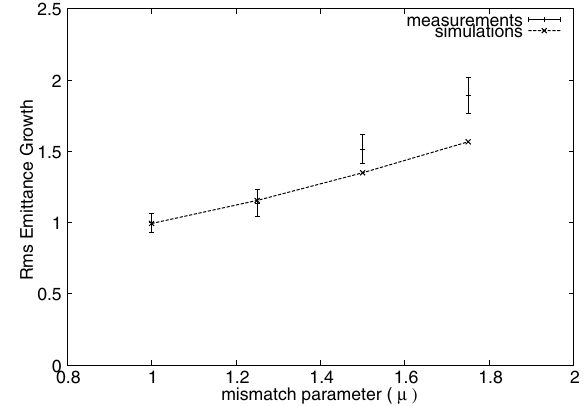
FIG. 11. Final rms-emittance growth from measurements (points with error bars) for breathing-mode mismatch at 75 mA as a function of mismatch parameter. Also shown (plots without error bars) are the simulation results for the initial LEBT/RFQ distribution.